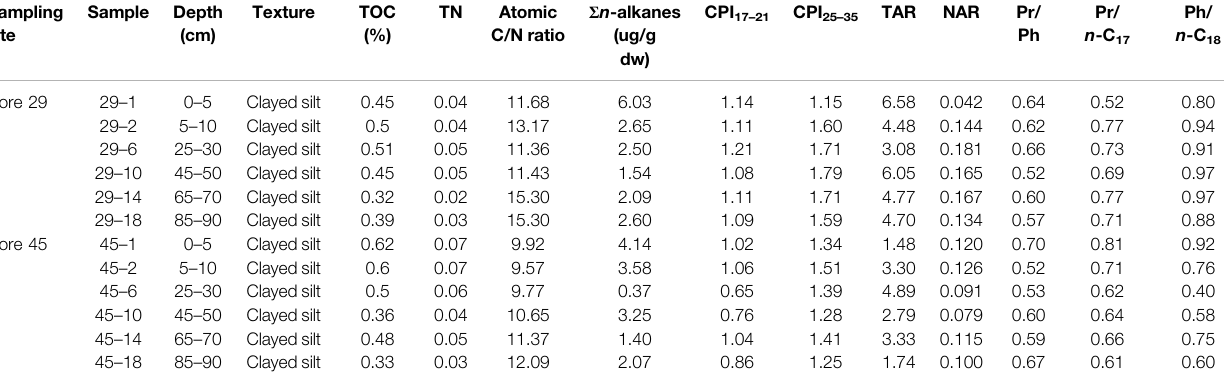
TABLE 1 | Compositions and parameters of bulk organic matter, concentrations of n -alkanes and hydrocarbon parameters for core sediments. Sampling site